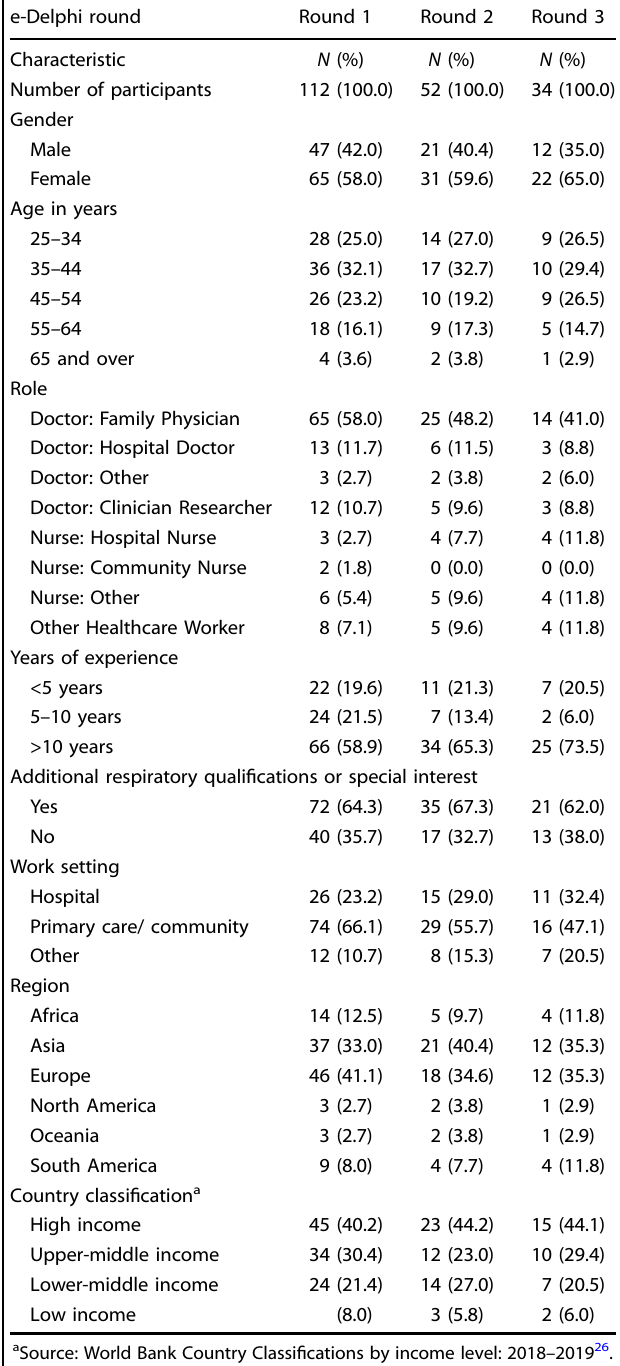
Table 1. Demographic characteristics of participants for e-Delphi rounds 1, 2 and